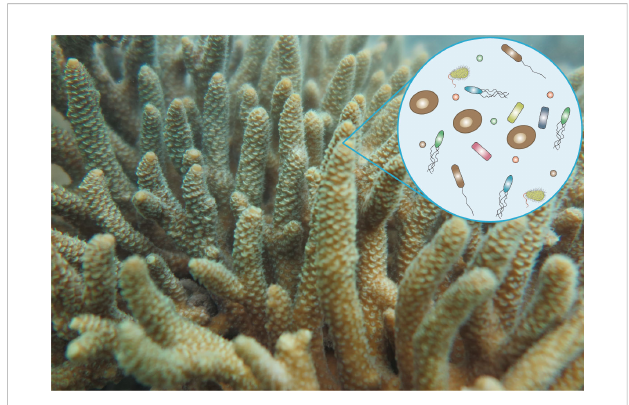
FIGURE 1 A typical case of symbioses between marine invertebrates and microbes: Coral and its associated